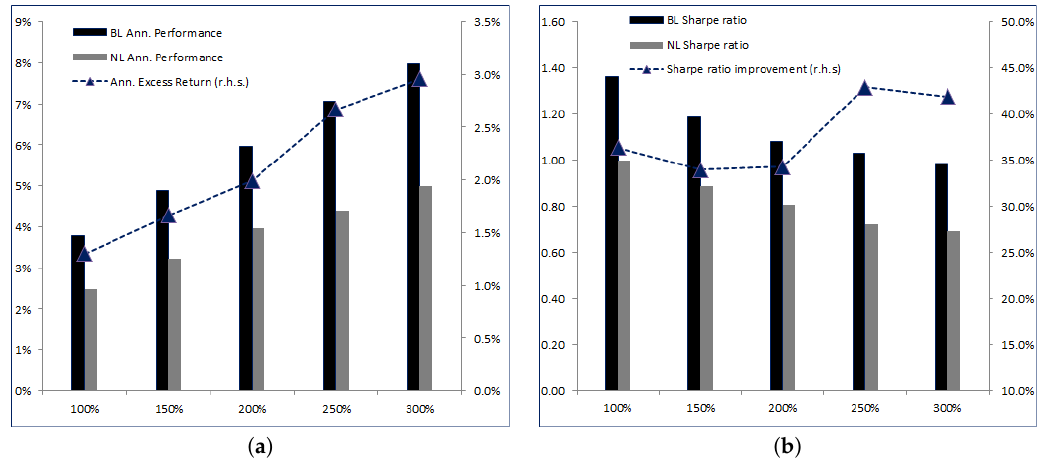
Figure 4. Annualized performances and excess returns of BL as a function of L ( a ); Sharpe ratios and relative improvement ( b